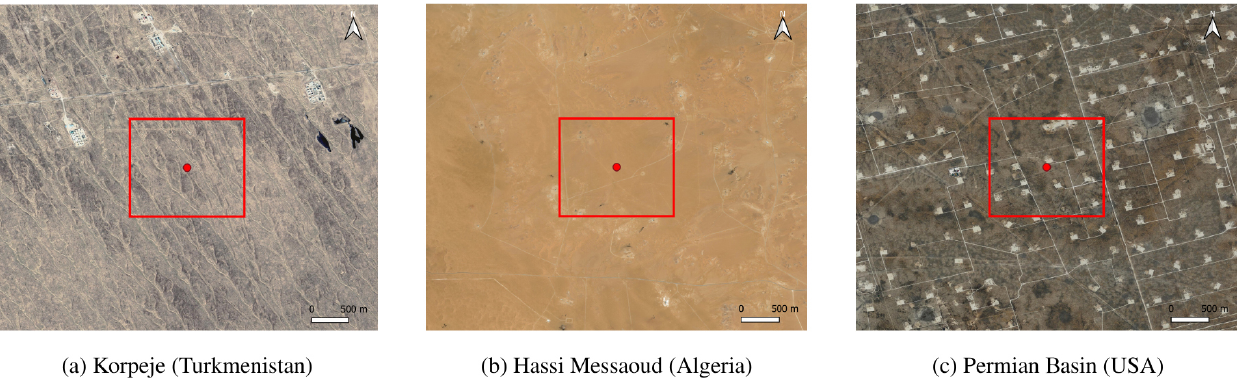
Figure 2. RGB image of the selected areas of (a) Korpeje (Turkmenistan), (b) Hassi Messaoud (Algeria), and (c) Permian Basin (USA). The selected area (red box) corresponds to 1500 × 1500m 2 centered at the latitude and longitude 38.493918 ◦ , 54.216550 ◦ (Korpeje), 31.82652 ◦ , 6.15011 ◦ (Hassi Messaoud), and 31.72070 ◦ , − 102.28663 ◦ (Permian Basin). Source map from © Google Earth and © Microsoft